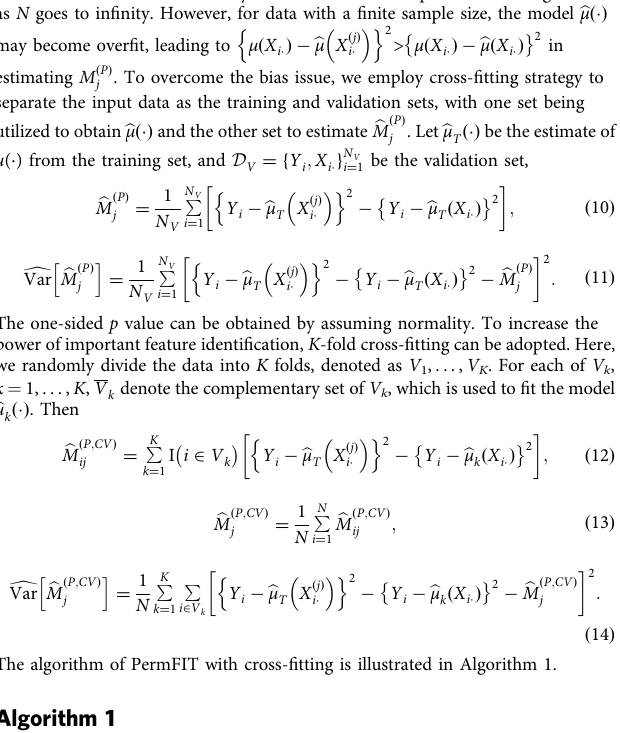
Algorithms for PermFIT 1:Randomly divide the data into K